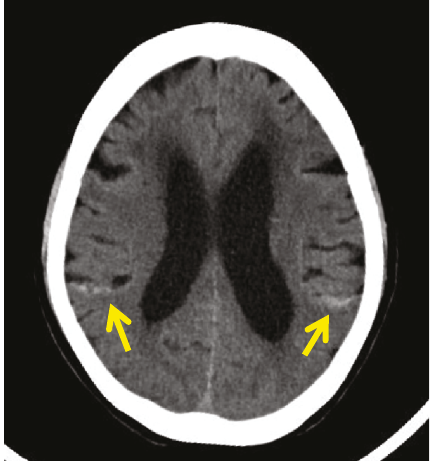
Figure 2: Axial noncontrast brain computed tomography showing a subarachnoid hemorrhage in the bilateral hemispheres at 7 days after